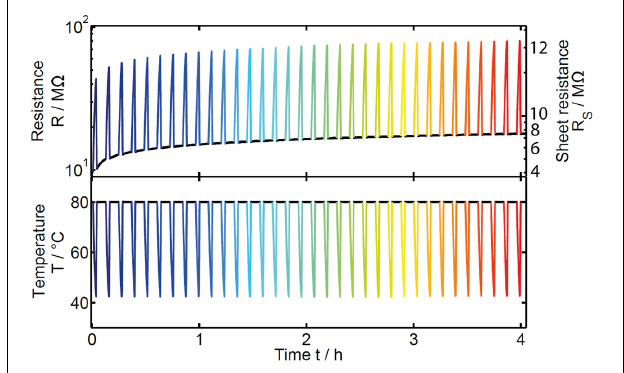
FIGURE 6 | Time-resolved experimental data for the resistance of a GeTe thin film sample (top diagram) as result of the application of a temperature profile (bottom diagram). The drift effect is visible as an increase of the resistance at constant annealing temperature of 80 ◦ C (black curve). Due to the semiconducting nature of the amorphous material the resistance strongly increases as the temperature is reduced. The color of the temperature dips reflects the point in time during the drift